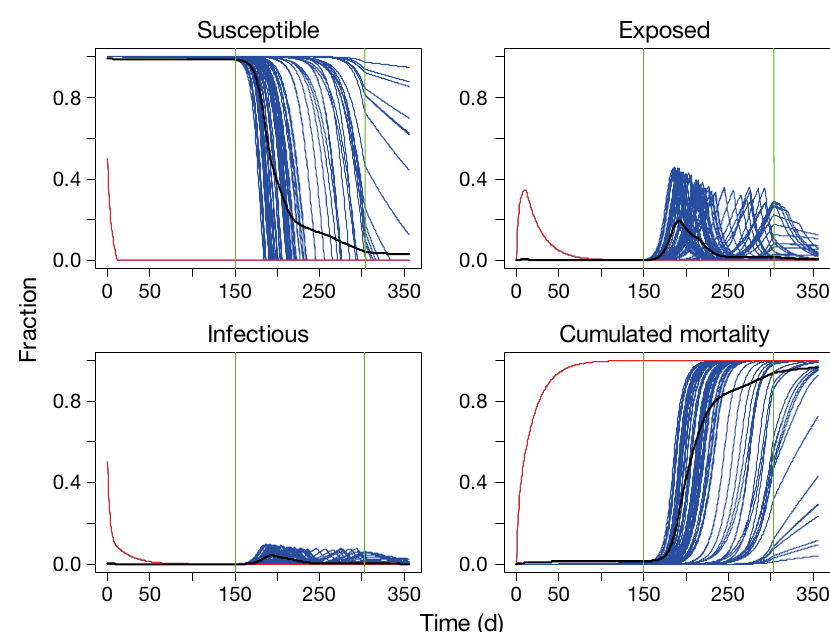
offset and intensity of mortality in other patches con- trasted with the dynamics of the initially infected patch. The decrease in E oysters coincided with the beginning of the summer season in the patches sur- rounding the patch initially in fected. The timing de - pended on the patch location but the mortality in - creased dramatically and reached a pla teau for almost all patches before the end of the simulated year. The S